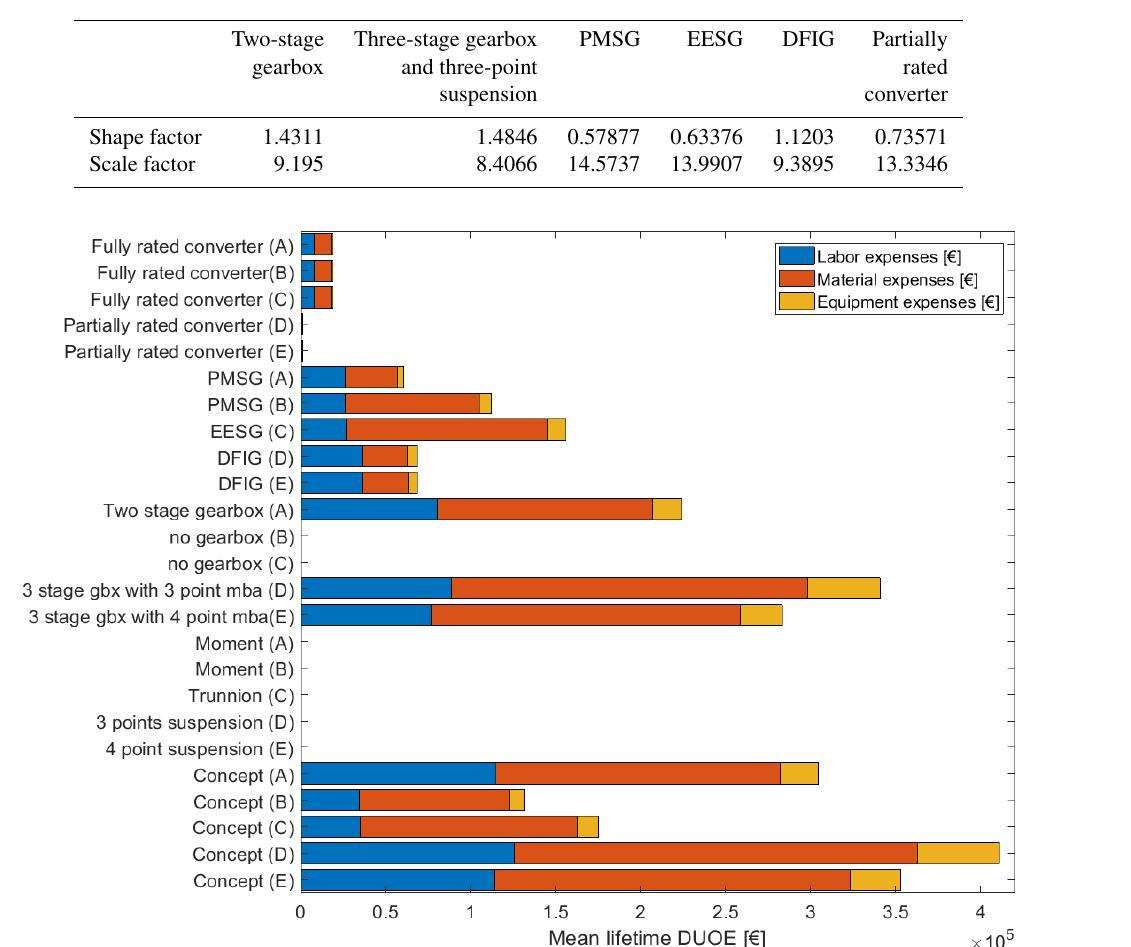
Table 4. Modeled Weibull parameter for failure behavior of different drivetrain components in different designs.